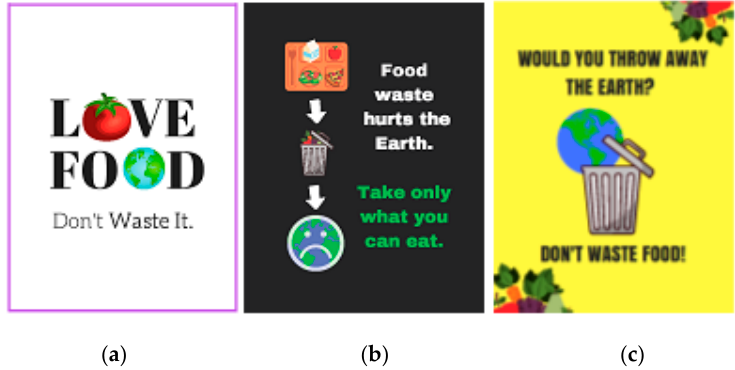
Figure 3. Food waste reduction poster winners, as voted on by school A ( n = 347) and school B ( n = 66) that were posted in school cafeteria during the final month of the intervention: ( a ) Top-voted poster at both schools ( b ) Second place poster at school A. ( c ) Second place poster at school B.